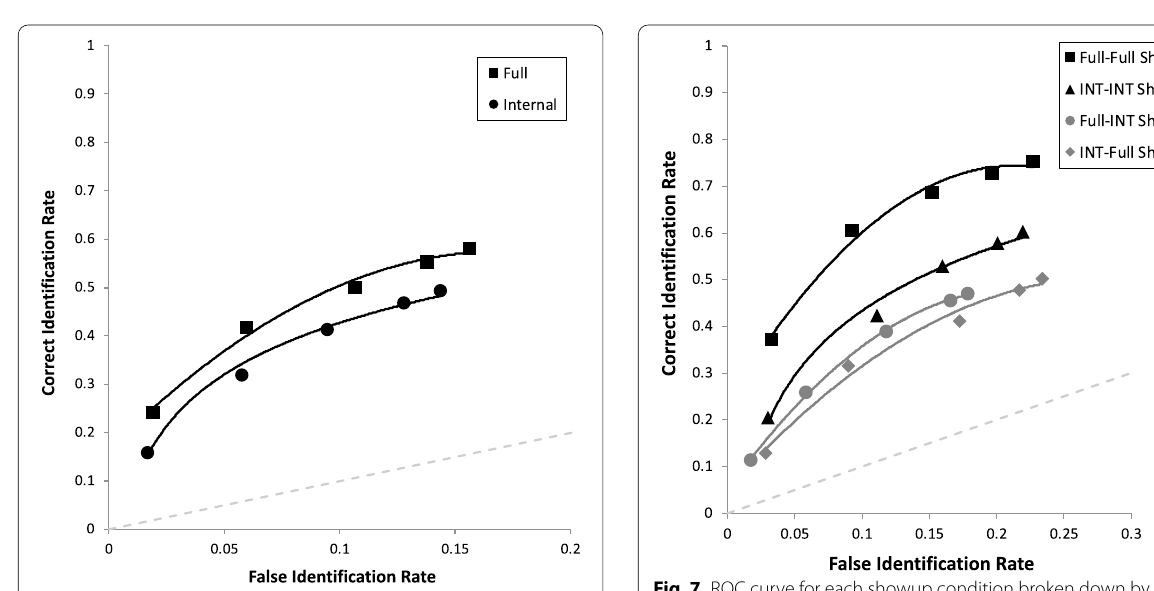
Fig. 5 ROC curve for faces tested as full versus internal, collapsed over all other manipulations